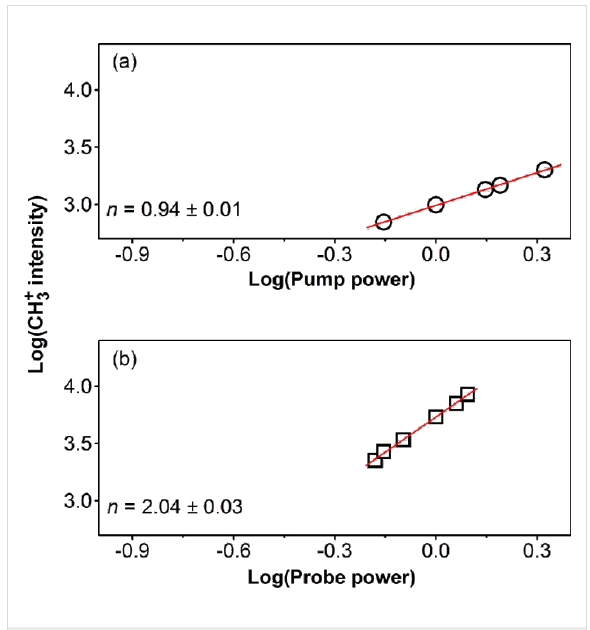
Figure 7: Intensity of the CH 3+ signal as a function of (a) pump power and (b) probe power. Both measurements (a) and (b) were performed for a pump–probe delay time of 140 fs. The straight lines represent linear fits to the experimental data yielding the indicated slopes n .